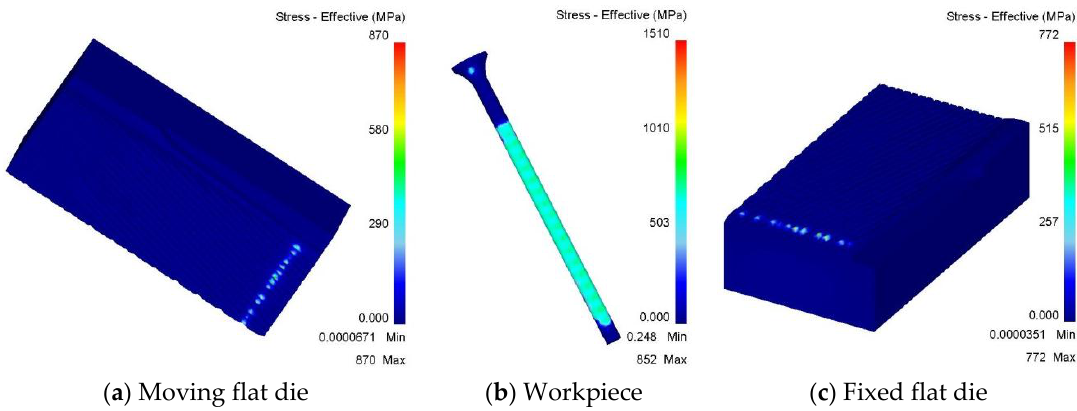
Figure 13. Effective stresses of flat dies and workpiece at a stroke distance of 8.89 mm.